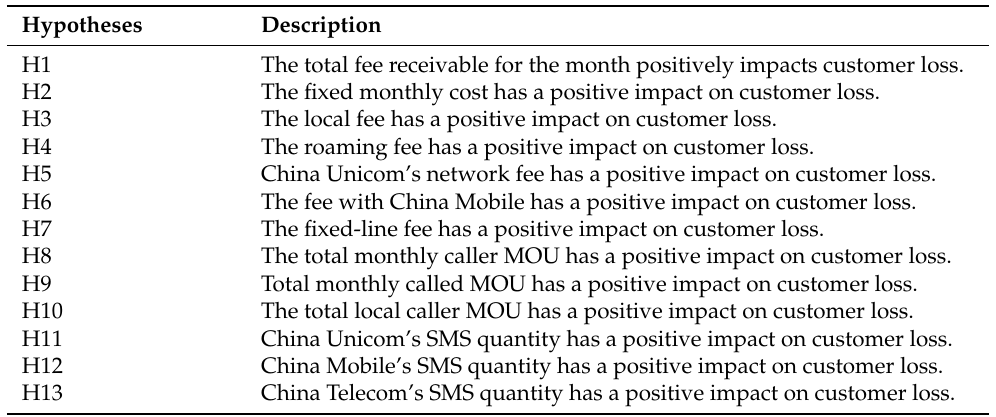
Table 1. The hypotheses of the